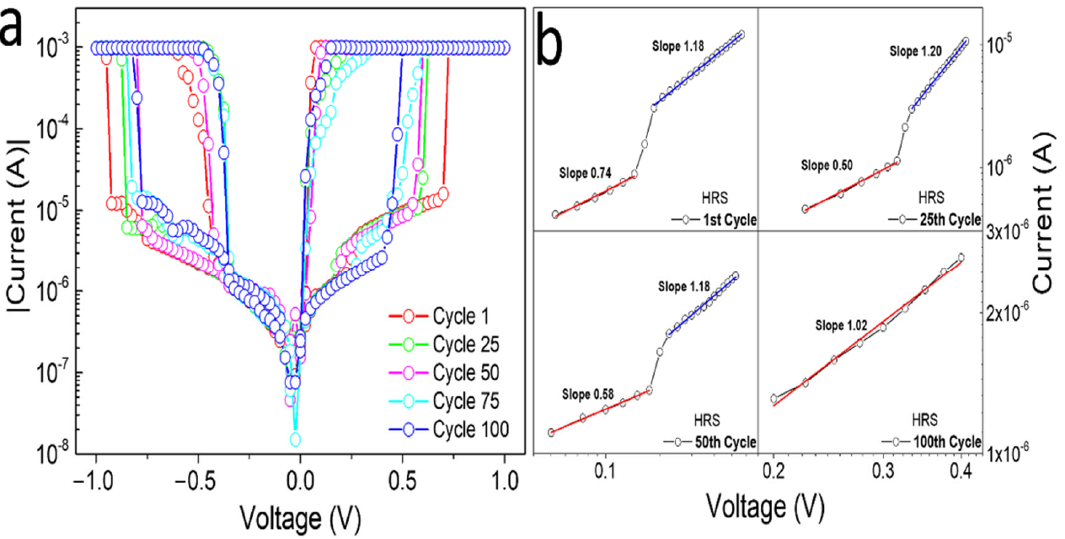
Figure 4. ( a ) I × V curves of PW samples during 100 cycles. ( b ) Log–log scale of I × V curves in the HRS region in the positive bias voltage for 1st, 25th, 50th, and 100th cycles.